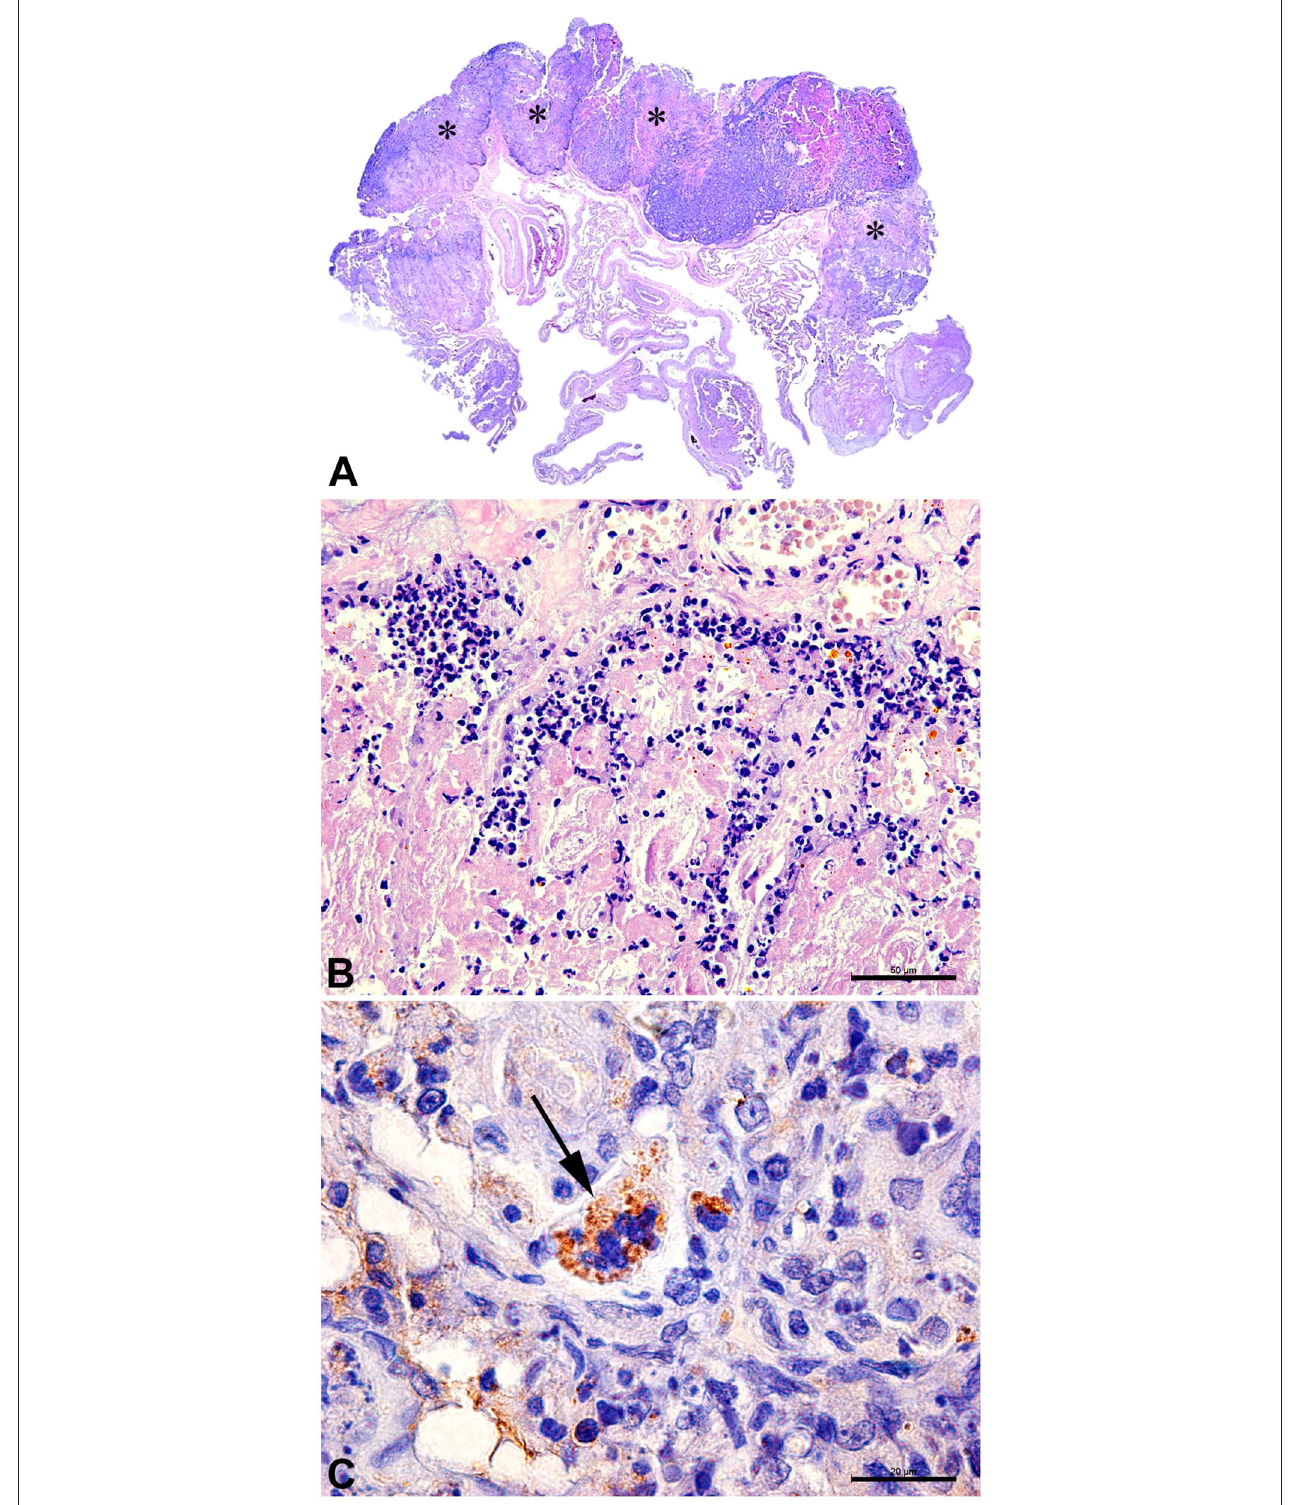
FIGURE 3 | Canine placenta. (A) Sub-macroscopic view of the placenta with multiple focally extensive areas of necrosis (*) characterizing a necrotizing placentitis. (B) Necrotic tissue and marked neutrophilic inflammatory infiltrate. HE Bar = 50 µ m. (C) Immunohistochemistry for detection of Brucella sp.: trophoblast with intracytoplasmatic immunolabed coccobacilli (arrow). Bar = 20 µ m.